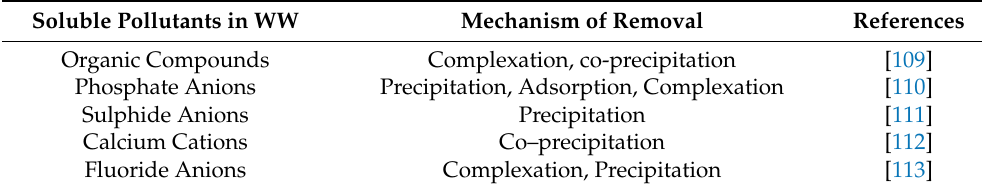
Table 3. Extraction mechanism of distinct soluble pollutant via metal hydroxides.